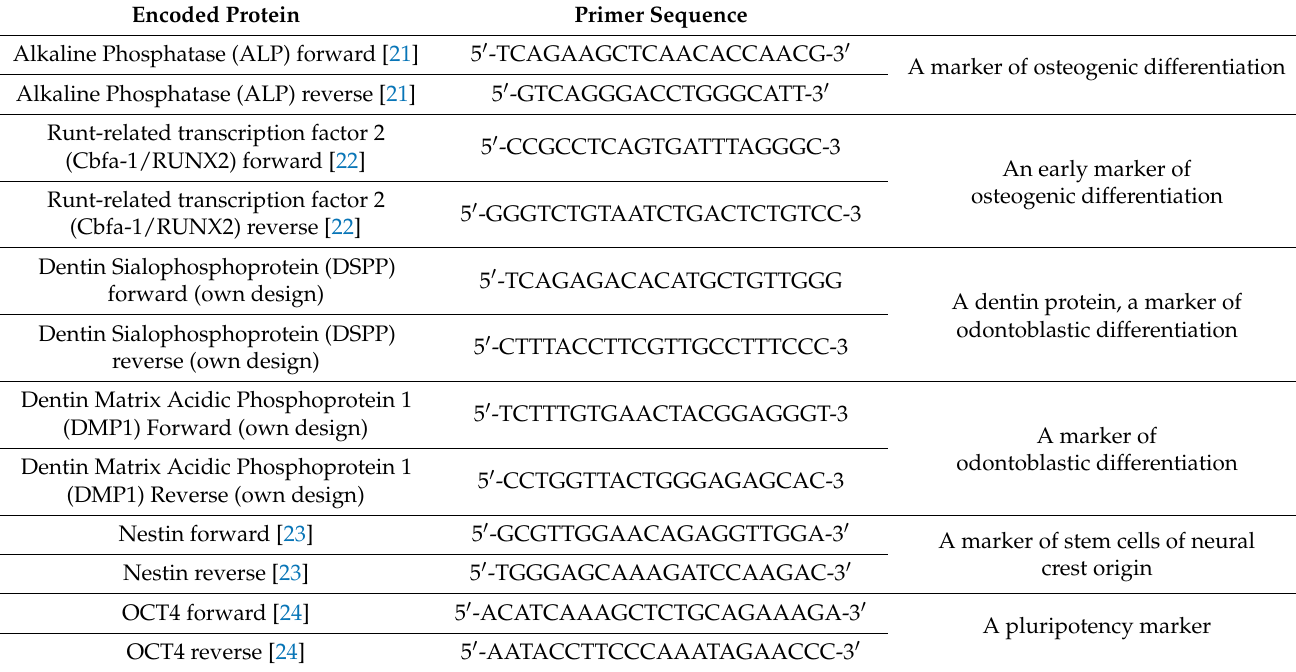
Table 1. List of primers used for quantification of targeted genes